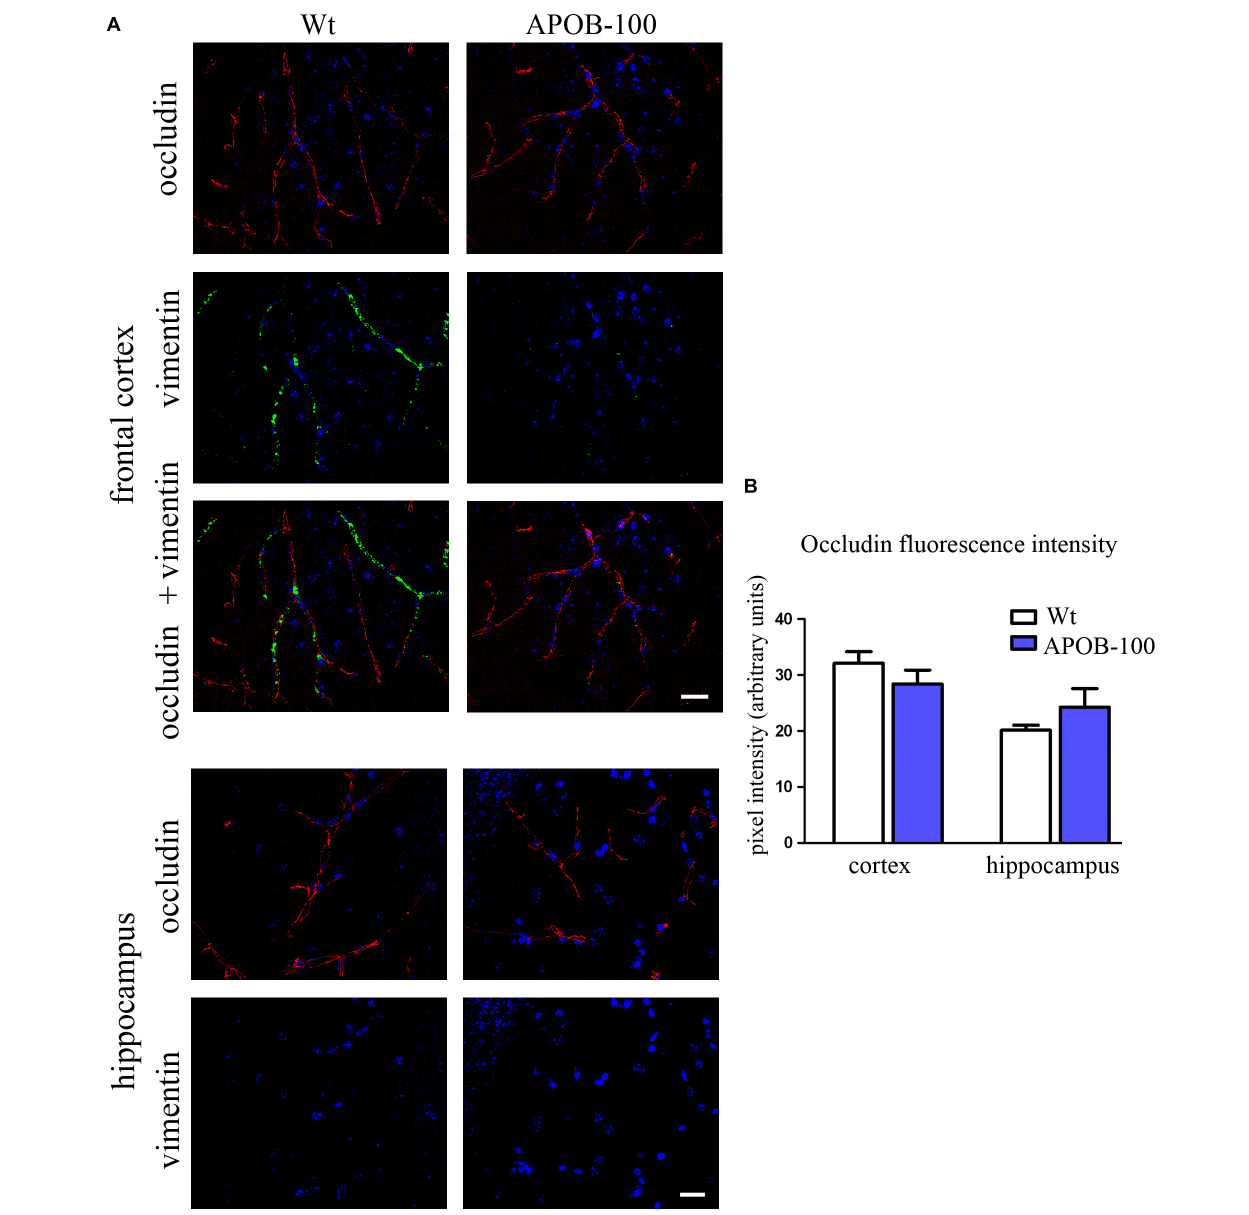
FIGURE 3 | Occludin (red) and vimentin (green) immunostaining pattern in the cortex and hippocampus of wild-type (Wt) and APOB-100 transgenic mice (APOB-100) counterstained with DAPI (blue) (A) . Scale bar: 20 µ m. Quantification of fluorescence intensity of occludin immunolabeling in the frontal cortex and hippocampus of Wt and APOB-100 transgenic mice (B)